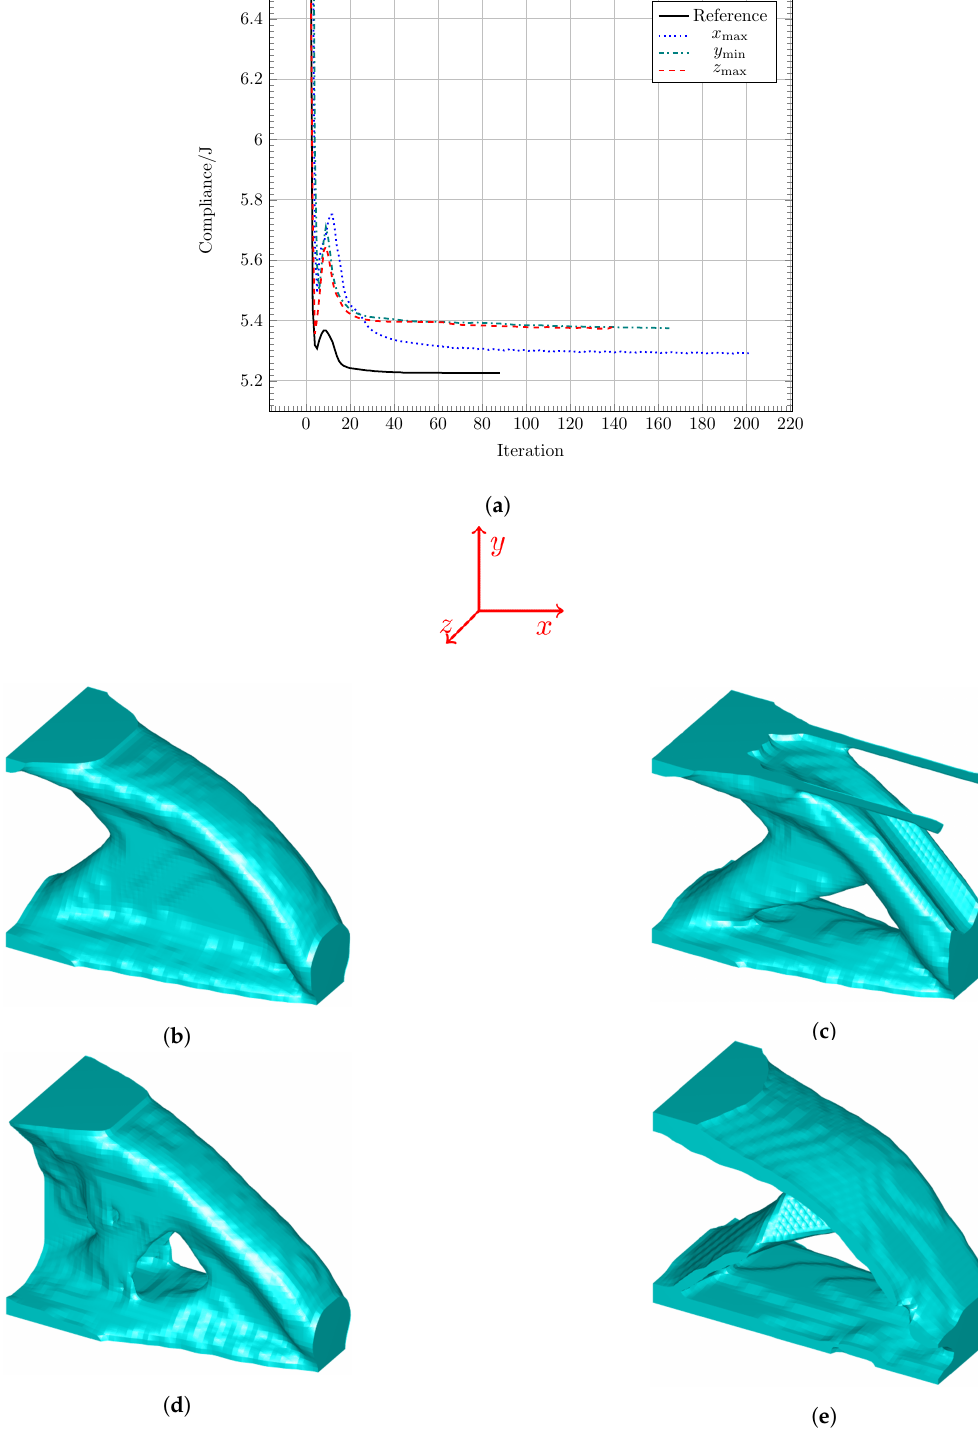
Figure 3. Convergence processes and optimized topologies with different build orientations: ( a ) convergence processes, ( b ) reference, ( c ) x max , ( d ) y min , ( e ) z max